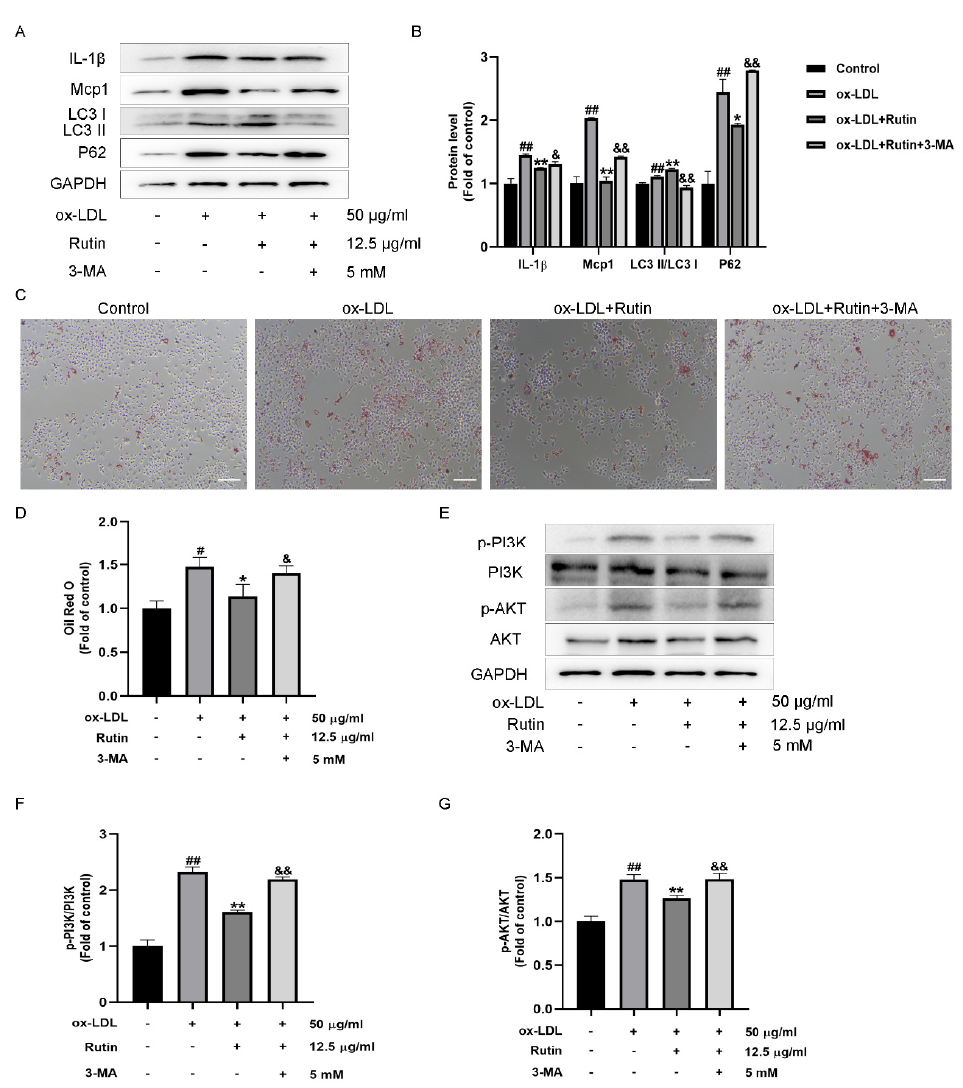
Figure 5. Rutin inhibits macrophage inflammation and foam cell formation via activating autophagy and regulating PI3K/ATK signaling. RAW264.7 cells were stimulated for 24 h with 12.5 µ g/mL rutin and subsequently treated for 24 h with 50 µ g/mL ox-LDL in the presence or absence of the autophagy inhibitor 3-MA. ( A , B ) Levels of IL-1 β , Mcp1, LC3II/LC3I and P62 expression. ( C , D ) Staining with oil red O (Scale bars = 100 µ m). ( E – G ) P-PI3K, PI3K, P-AKT and AKT expression. # p < 0.05, ## p < 0.01 vs. control group; * p < 0.05, ** p < 0.01 vs. ox-LDL-treated group; & p < 0.05, && p < 0.01 vs. ox-LDL and rutin treatment group. Data are presented as mean ± SD.